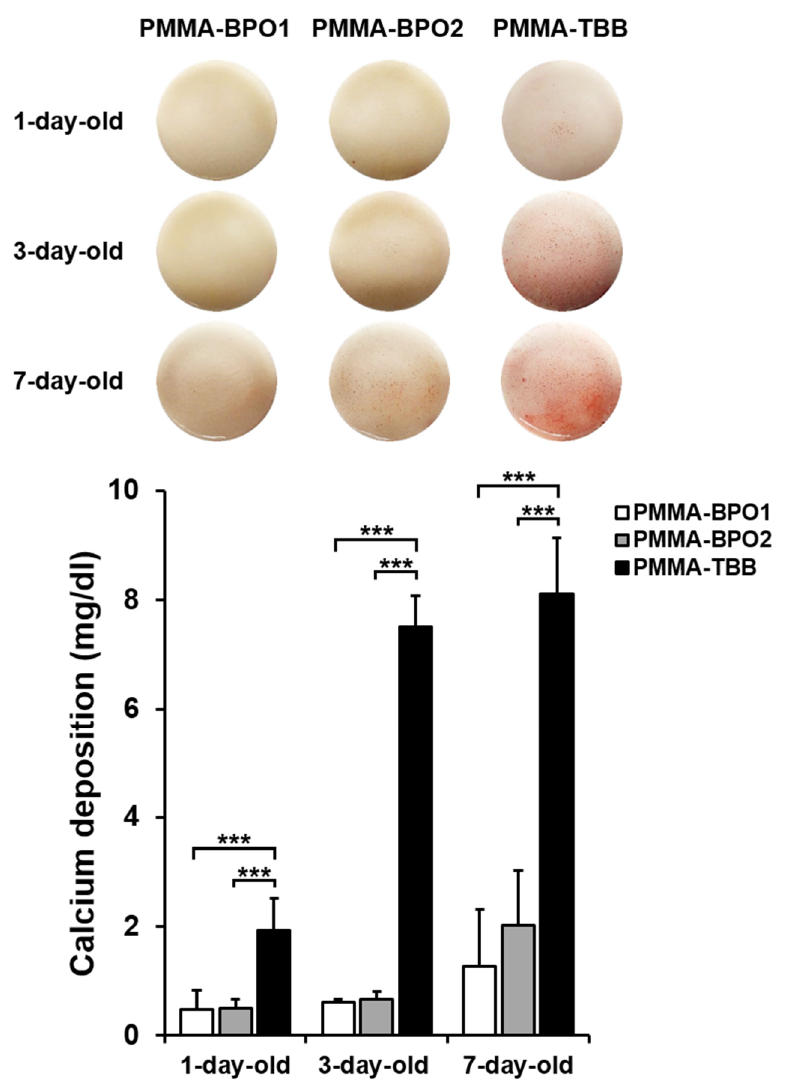
Figure 5. Matrix calcium deposition within osteoblastic cultures. Representative images of Alizarin red-stained cultures on day 15 of culture ( top ) and the result of colorimetric detection of total calcium deposition performed on the same day are presented. Data are shown as mean ± SD ( n = 3). Statistical differences between the three groups are shown (two-way ANOVA followed by Bonferroni test, *** p < 0.001).